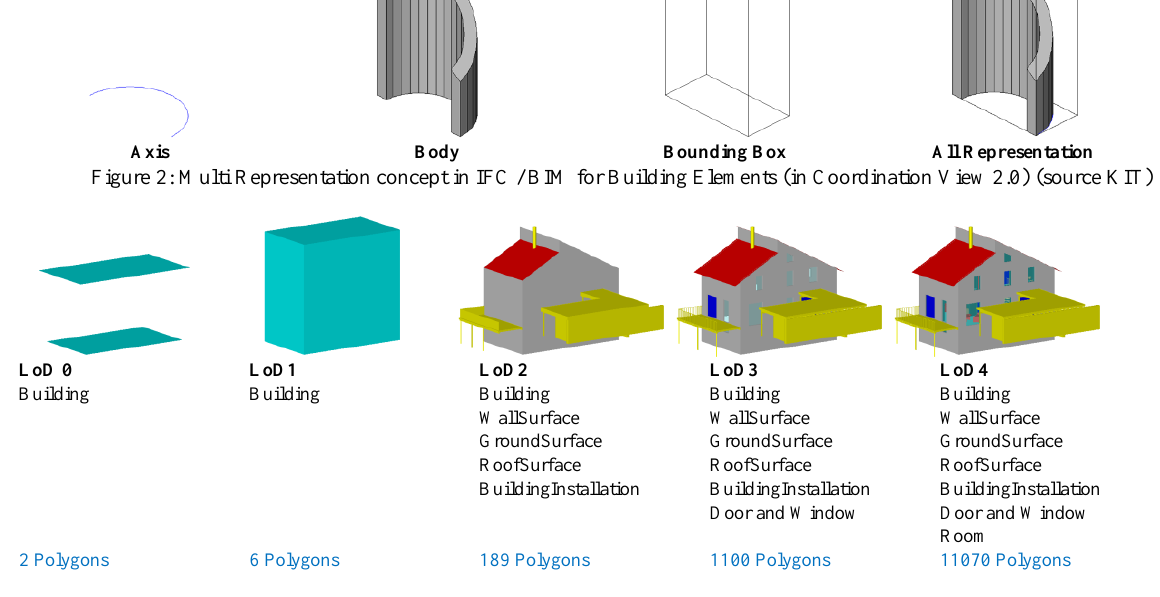
Figure 3: Geometric and semantic Level of Detail for buildings in CityGML 2.0 (source